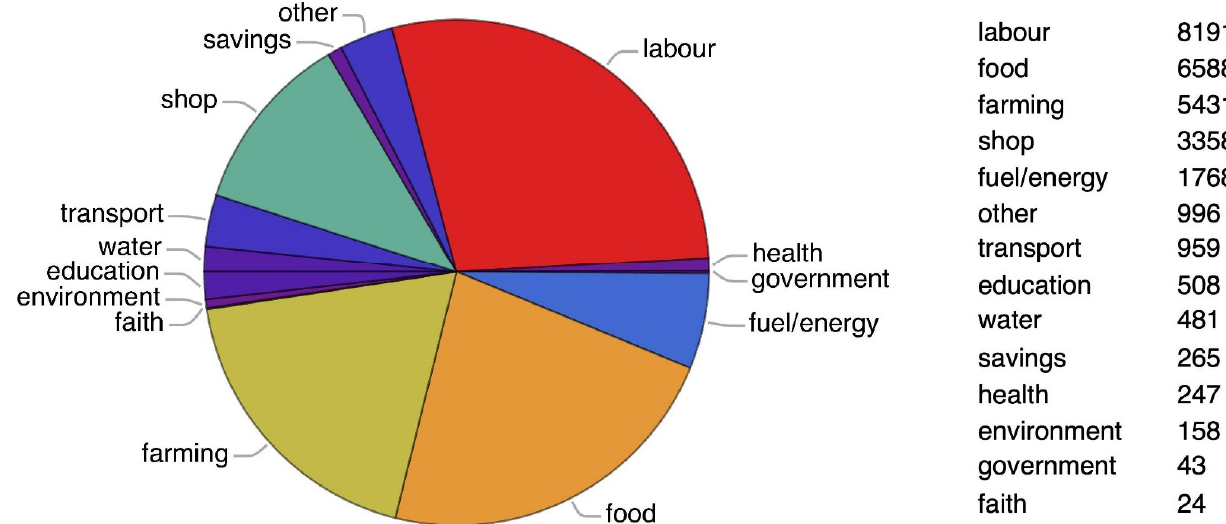
Figure 7. Business-type of all registered standard members and chamas since September 2018 to July 2021. Members choose one of 14 Business Sectors when registering. Members can update their member profile if they choose.